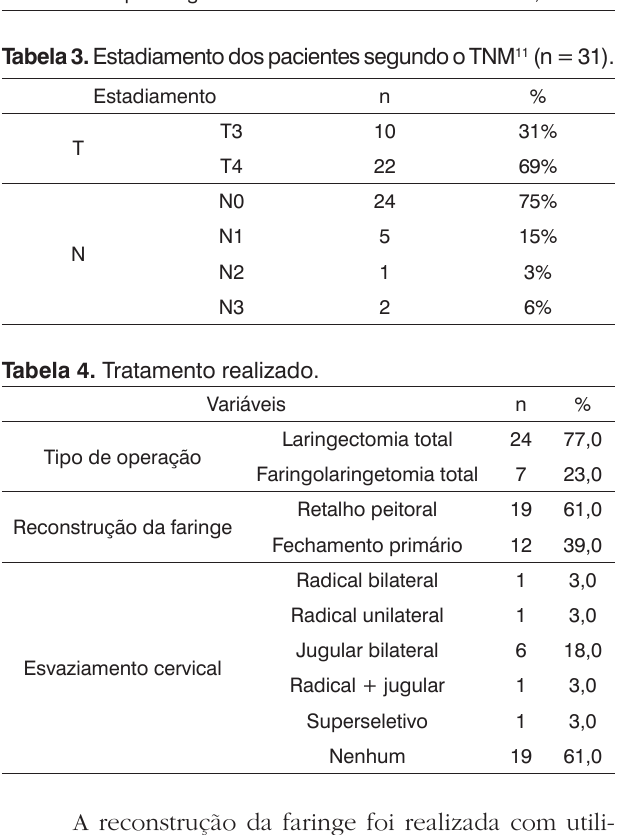
Tabela 6. Comparação dos tipos de fechamento da faringe em relação às variáveis tempo de uso do CNE, reintrodução da dieta oral e aparecimento da fístula salivar (n =